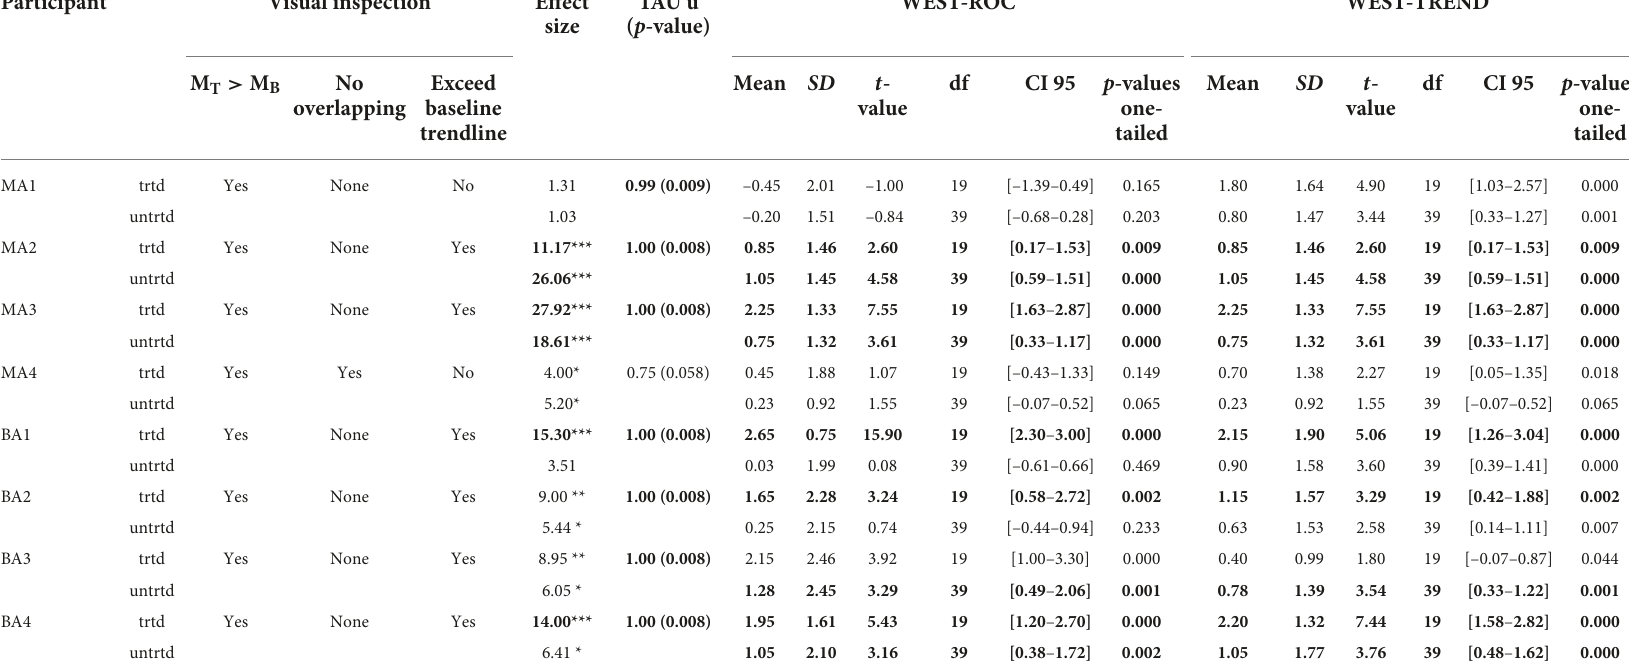
TABLE 3 Case-study result summary: Evidence of acquisition and within-level generalization comparing baseline and treatment performance